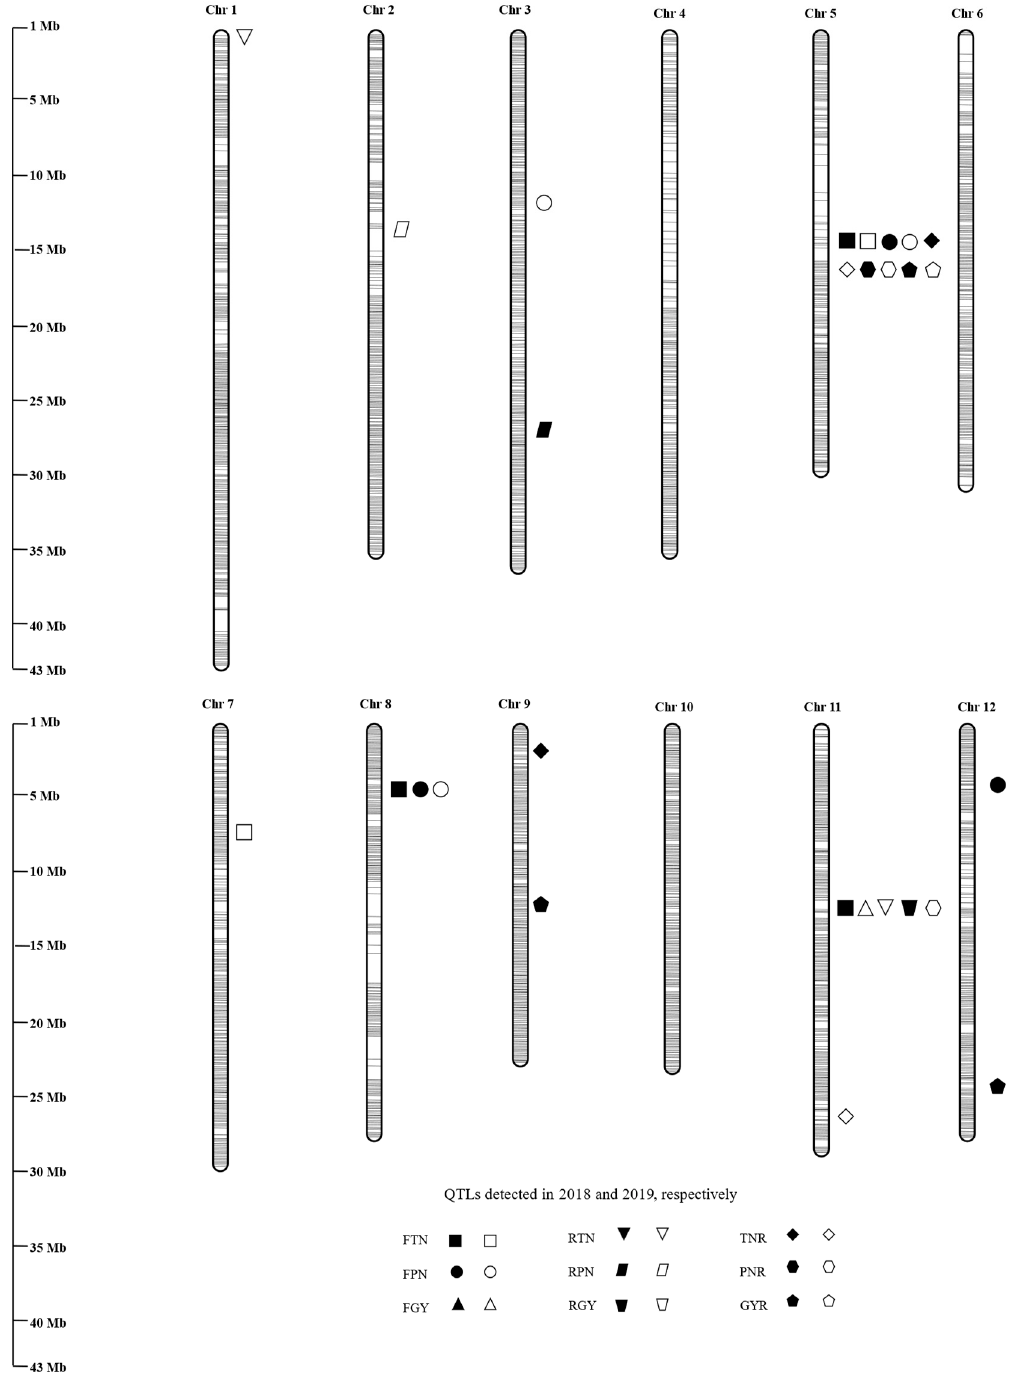
Figure 2. Genome distribution of M-QTLs detected for ratooning ability in the IL population derived from MH63 and 02428. FTN, maximum tiller number per plant in the first season; FPN, panicle number per plant in the first season; FGY, grain yield per plant in the first season; RTN, maximum tiller number per plant in the ratoon season; RPN, panicle number per plant in the ratoon season; RGY, grain yield per plant in the ratoon season; TNR, maximum tiller number ratio of RTN to FTN; PNR, panicle number ratio of RPN to FPN; GYR, grain yield ratio of RGY to FGY. In the first season, a total of 9 QTLs were identified, including four, four, and one QTLs for FTN, FPN, and FGY, respectively (Table 3; Figure 2). Among them, 3 QTLs ( qFTN8 , qFTN11 , and qFPN12 ) were detected only in 2018, accounting for 8.69–16.71% of the phenotypic variations, while qFTN7 , qFPN3 , and qFGY11 were identified only in 2019, explaining 8.11–10.66% of the phenotypic